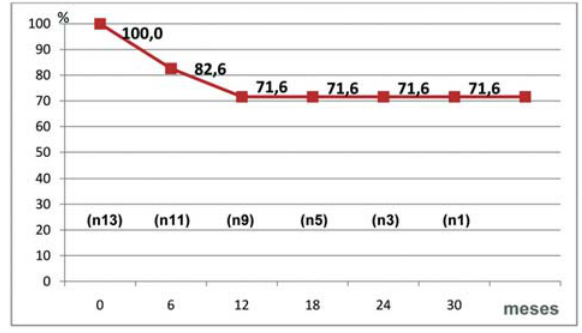
Fig. 4 - Curva atuarial de sobrevivência de pacientes submetidos à papilopexia cruzada e substituição valvar com constrição do anel com insuficiência cardíaca avançada. n=